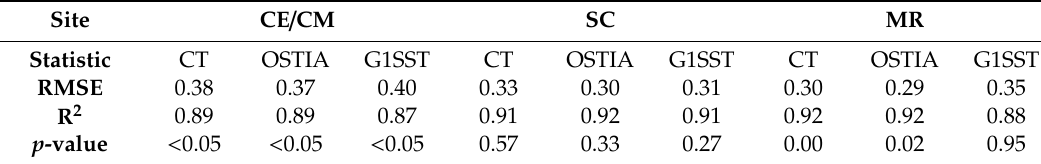
Figure 10. Scatter plots with linear regression of the averaged in situ temperature against the different three different remote sensing SST datasets for Margarita Reef. Table 9. Test statistics (root mean square error (RMSE); R 2 ; p -value) from the linear regression models, with the three satellite-based SST datasets (CoralTemp = CT; OSTIA; G1SST) as the predictor for the in situ temperature at the three di ff erent sites (Cayo E Enrique and Cayo Mario = CE / CM; San Cristobal = SC; Margarita Reef =